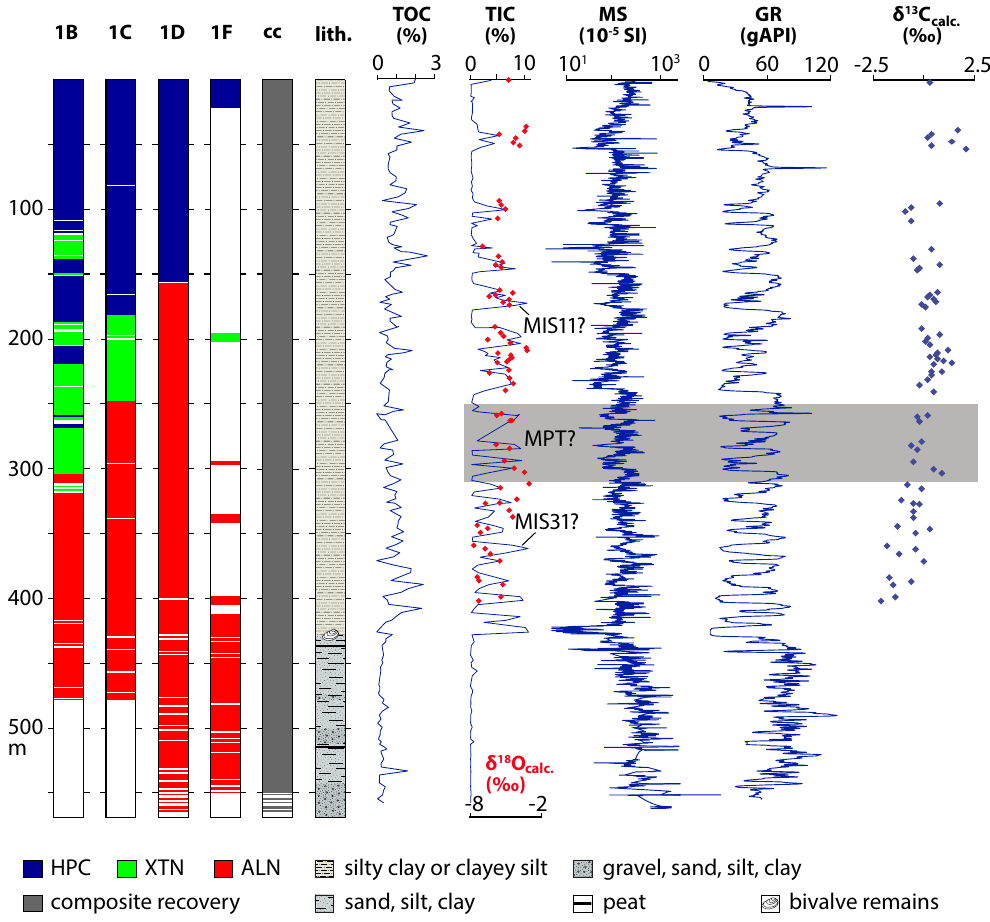
Figure 5. Core recovery and lithology from DEEP site. Colours indicate the di ff erent coring tools used for the four parallel holes 1B, 1C, 1D, and 1F with deeper penetration. A hydraulic piston corer (HPC, blue) was used for the recovery of the upper sediment sequences. The relatively soft consistency of these sediments allows penetration of a 3m long piston corer by hydraulic pressure. Rotation drill tools were used for the deeper and more consolidated sediments and comprise the extended nose (XTN, green), where the drill bits stand back by about 12cm from the core barrel front, and the Alien (ALN, red), where the drill bits are placed directly at the core barrel front. 1A and 1E are not displayed as coring was restricted to surface sediments ( < 5m) using the HPC. The core composite (cc) is based on core correlation of individual holes based on field depth measurements. White parts indicate no core recovery due to gaps. The lithology (lith.), total organic carbon (TOC), total inorganic carbon (TIC), and stable isotope ( δ 18 O calc. , red dots in the TIC curve, and δ 13 C calc. to the right) measurements are based on core catcher samples. Magnetic susceptibility (MS) was measured in 2cm intervals on a multi-sensor core logger (MSCL) equipped with a whole core loop sensor. Spectral gamma ray (GR) is based on downhole logging data run through the drill pipe with 10cm vertical resolution. The grey bar indicates tentatively the Middle Pleistocene transition (MPT). Marine isotope stages (MIS) 11 and 31 are extrapolated from glacial / interglacial changes in TIC